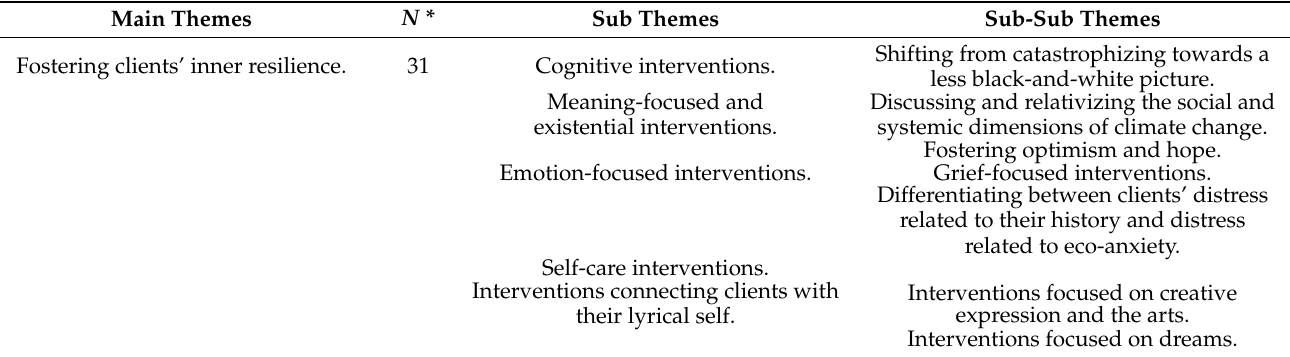
Table 1. Eco-anxiety